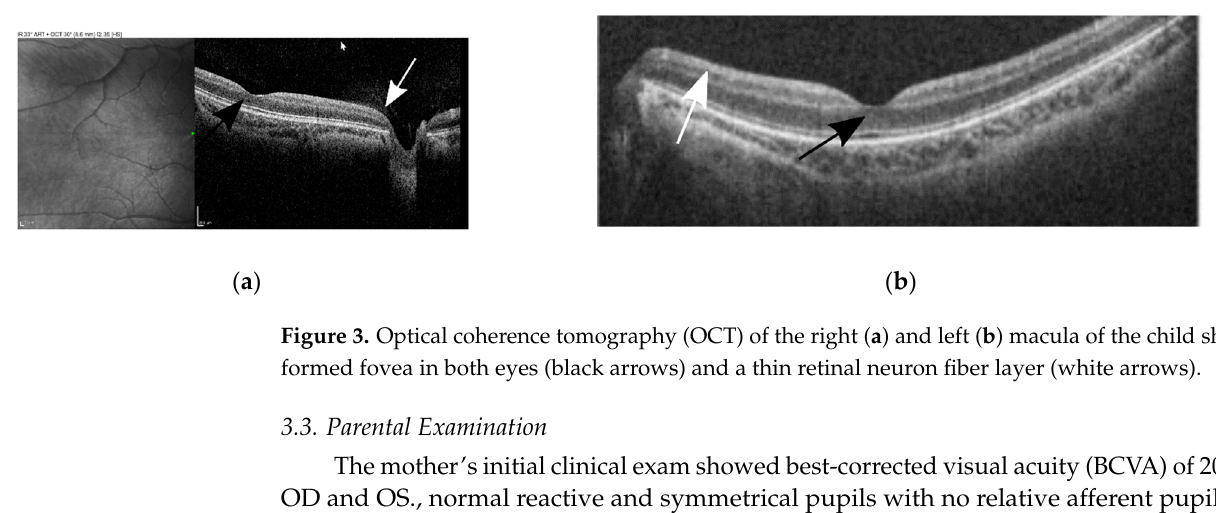
Table 1. Summary of previous cases of patients with compound heterozygous optic atrophy 1